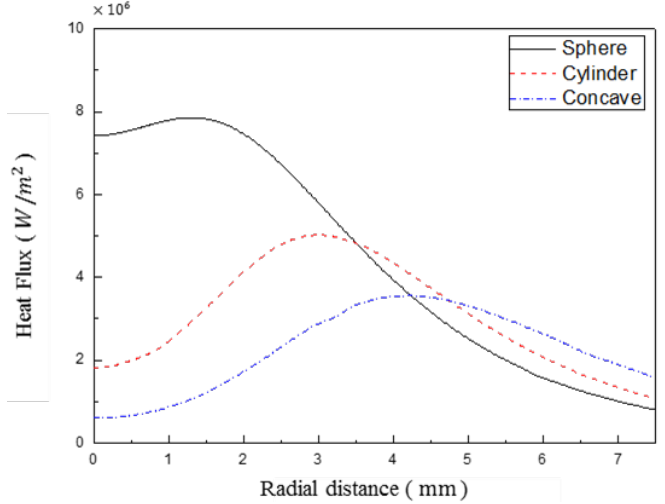
Figure 9. Heat flux on the anode according to obstruction structure shape.